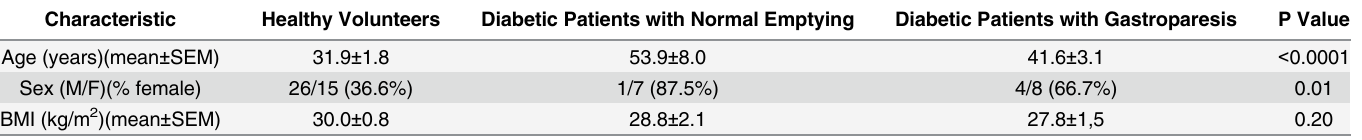
Table 1. Subject Characteristics for Each of the Three Groups. Characteristic Diabetic Patients with Normal Emptying Diabetic Patients with